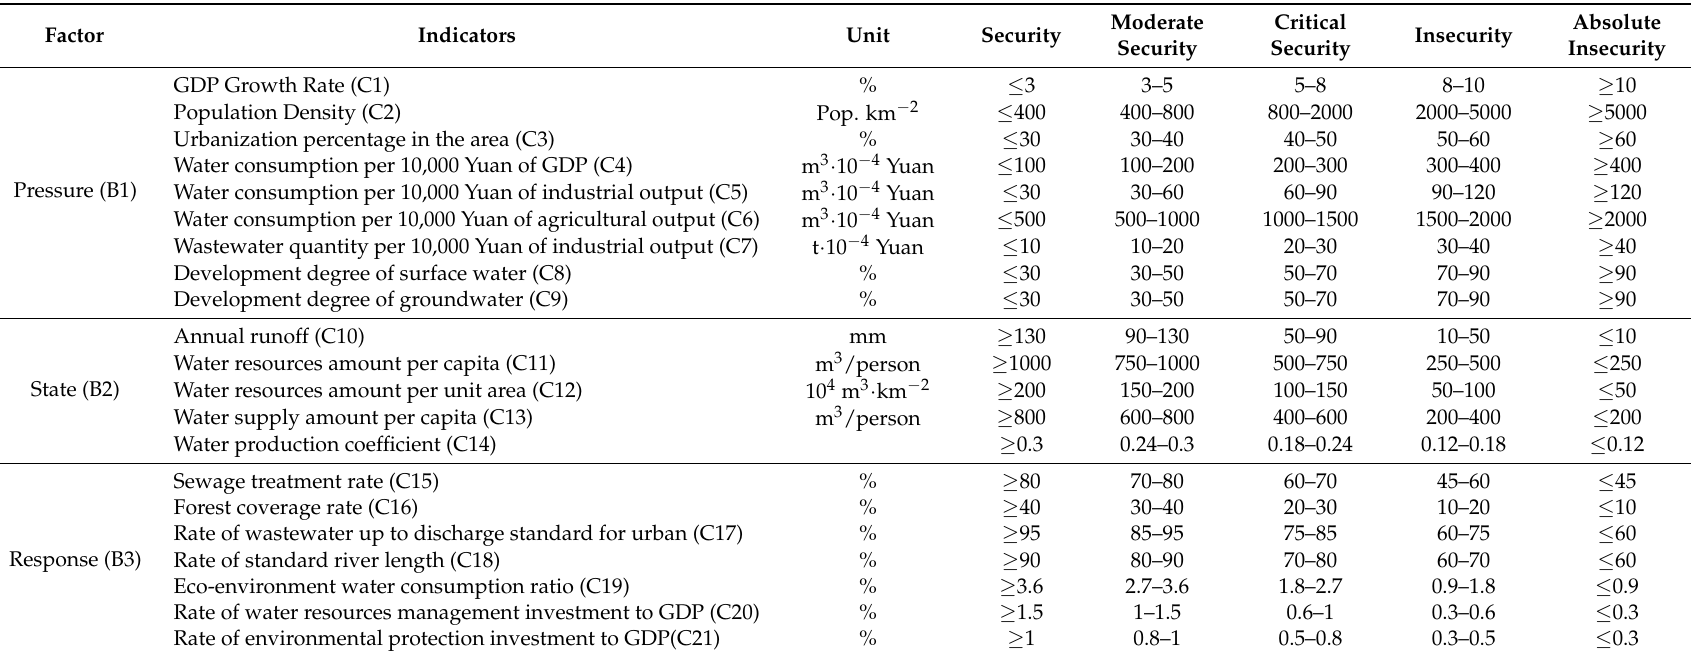
Table 2. Grade classification of water resource